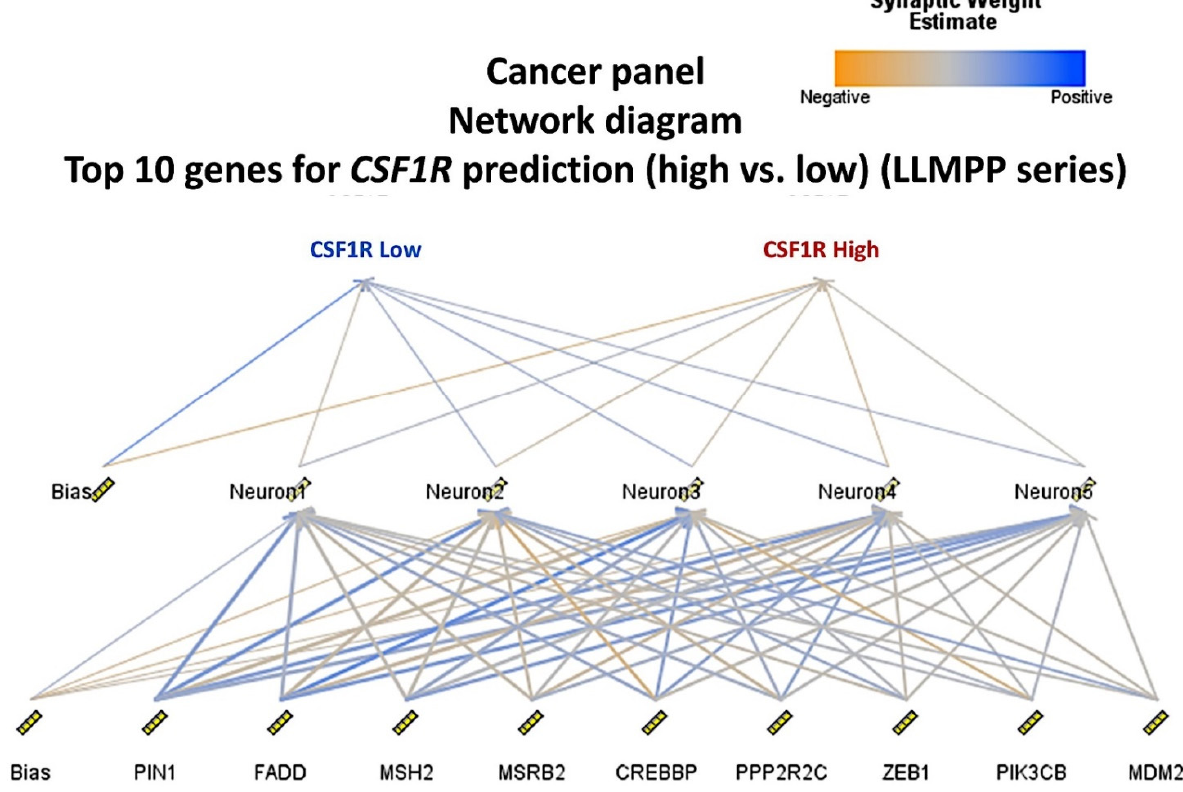
Figure 9. Multilayer perceptron between the top 10 genes of the cancer panel and CSF1R expression levels (LLMPP data). This figure shows the neural network diagram for the top 10 most relevant genes of the immuno-oncology cancer panel that predict the CSF1R expression. Table 8. Correlation between the gene expression of the top cancer panel genes of the multilayer